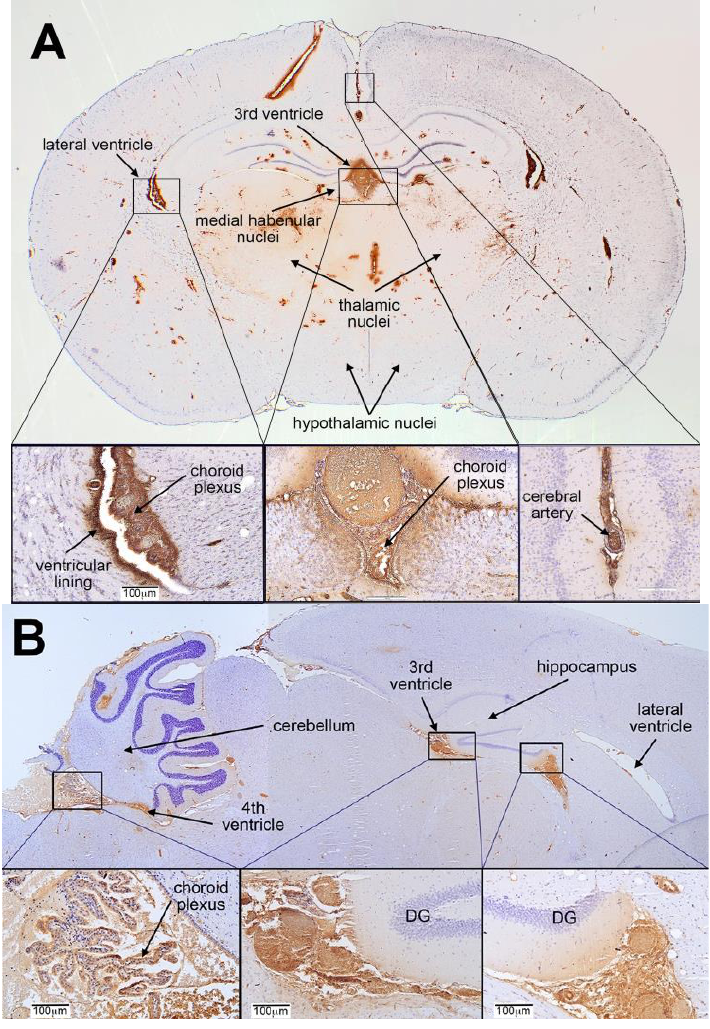
Figure 3. ( A ). Localization of FR α Ab in the PND23 cerebrum. Coronal section shows FR Ab distri- bution within the blood vessels, microvasculature and the choroid plexus within the ventricles. ( B ). Localization of FR α Ab in the PND23 cerebellum. Sagittal section of the brain shows FR α Ab distribu- tion in the blood vessels and in the vasculature of the 3rd and 4th ventricles including the choroid plexus. (Abbreviation: DG = dentate gyrus).